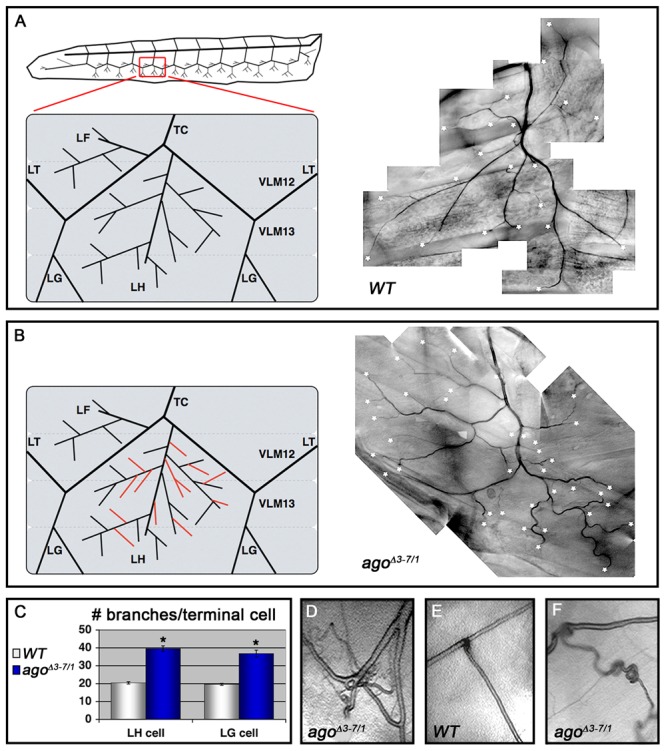

ago
Δ3–7/1 larvae display a wide range of tracheal terminal branch phenotypes.(A,B) Schematic (left) and representative photomicrograph showing branching of LH lateral terminal cells in control (A) and ago
Δ3–7/1 (B) larvae. Branch termini are indicated with asterisks. (C) Quantification of branch number per LH (left) and LG (right) terminal cell in the indicated genotypes (*p<0.001 relative to control). (D) ago
Δ3–7/1 larva displaying terminal branch tangling. (E,F) Ganglionic tracheal branches in control (E) and ago
Δ3–7/1 (F) larvae. Ringlet-shaped branches and tangles occur in approximately 25% of ago
Δ3–7/1 larvae.